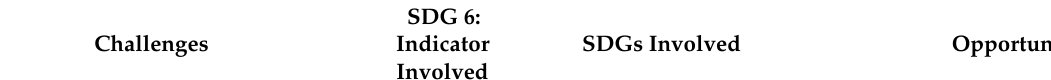
Table 5. Main challenges and opportunities in the Mediterranean